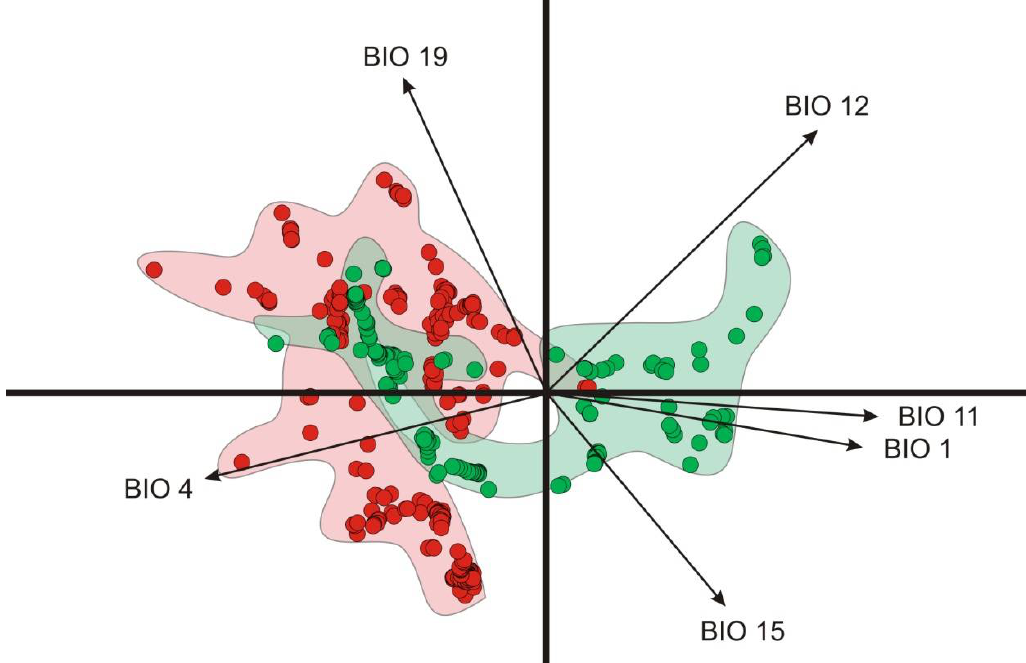
Figure 3 . PCA biplot that represents the environmental space in the global realized niche of the species O. drummondii using the 19 bioclimatic variables of WorldClim. The dots show the occurrence records that were used to calibrate the models. Red and green color shaded areas correspond to the non-native and native areas. Vectors represent bioclimatic variables that are closer to the average values of occurrence records in each axis. Annual Mean Temperature (BIO1), Temperature Seasonality (BIO4), Temperature of Coldest Quarter (BIO11), annual precipitation (BIO12), Mean and Precipitation Seasonality (BIO15), and Precipitation of Coldest Quarter (BIO19).